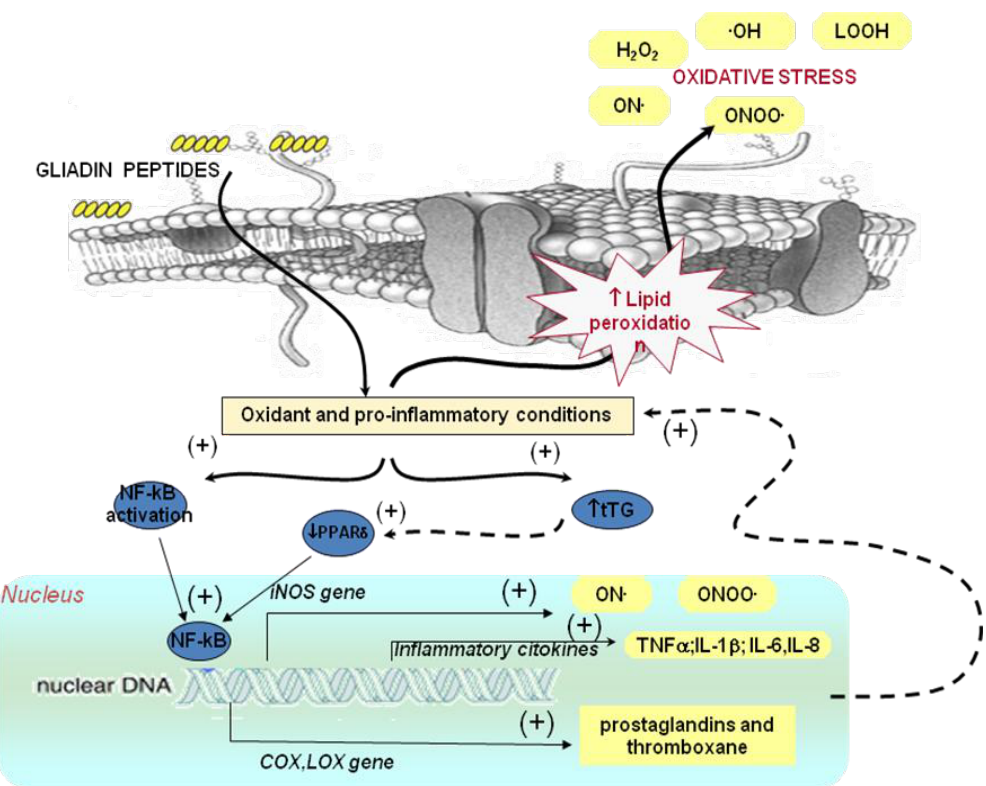
Figure 2. Effect of gluten on oxidative stress and gene expression . Alteration in oxidative balance induced by gliadin peptides in enterocytes is involved in the activation of transcription factor NF-κB. NF-κB activation induces the transcription of